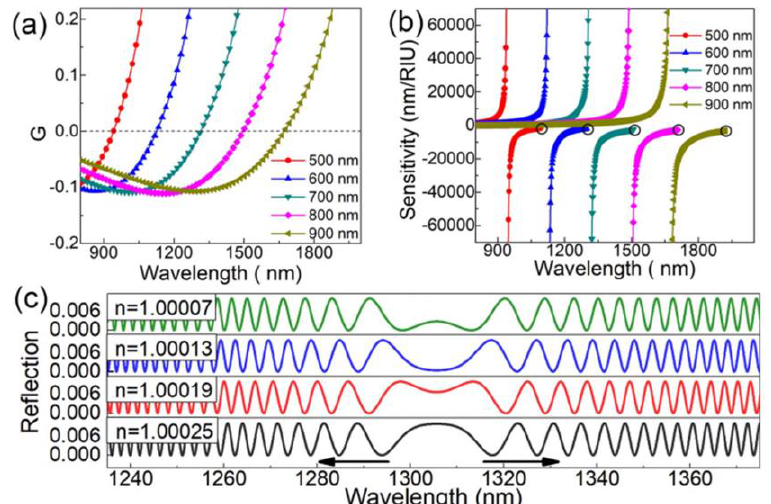
Figure 1. Typical structure of microfiber coupler.